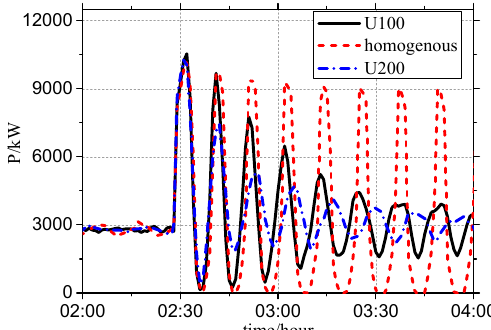
Figure 5. The aggregated responses of 2000 homogeneous and heterogeneous TCLs.